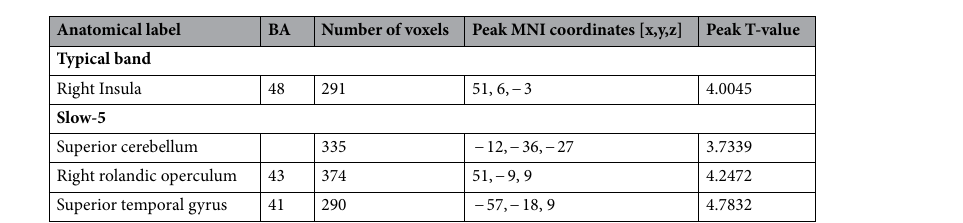
Figure 2. Brain regions with abnormal fALFF in typical low-frequency range and at slow-5 band in NE children. The results were corrected by GRF (voxel P < 0.05, cluster P < 0.05). More details of these regions were described in Table 3. ( A ) Left insula with increased fALFF in typical low-frequency range (0.01–0.08 Hz). ( B ) Superior cerebellum, right rolandic operculum, superior temporal gyrus with increased fALFF in slow-5 band (0.01–0.027 Hz).